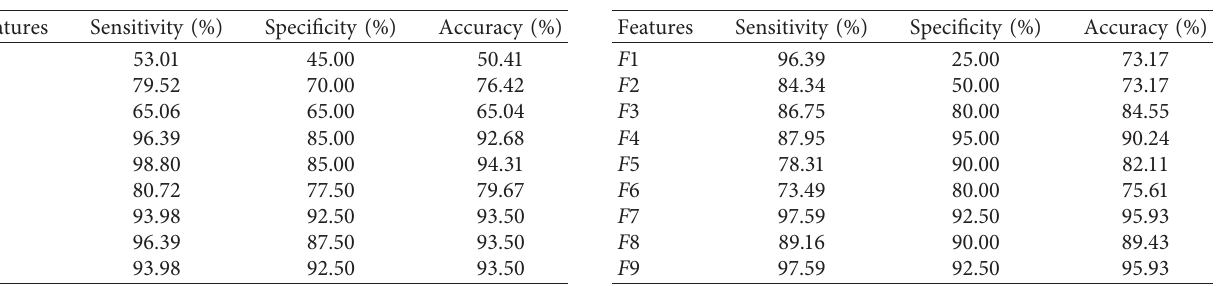
Table 2: Classification results using data from first 128 cycles. Table 3: Classification results using data from first 256 cycles.